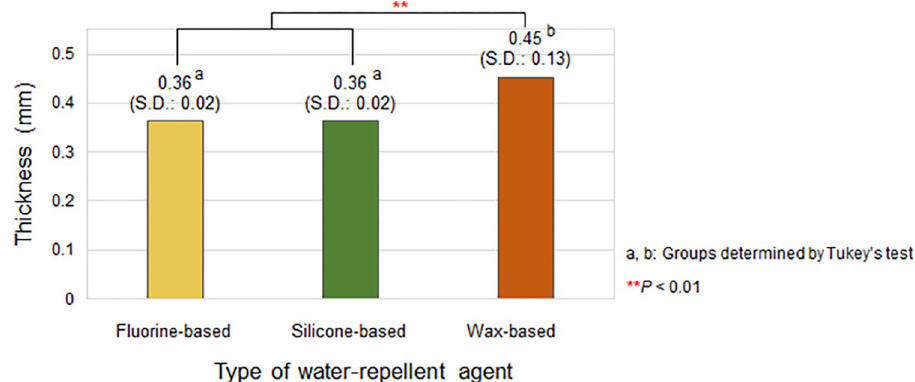
Fig 1. Thickness of the cotton woven fabric according to the type of water-repellent agent. The result is the average thickness of the fabrics of all numbers of coating layers under each water-repellent agent condition.